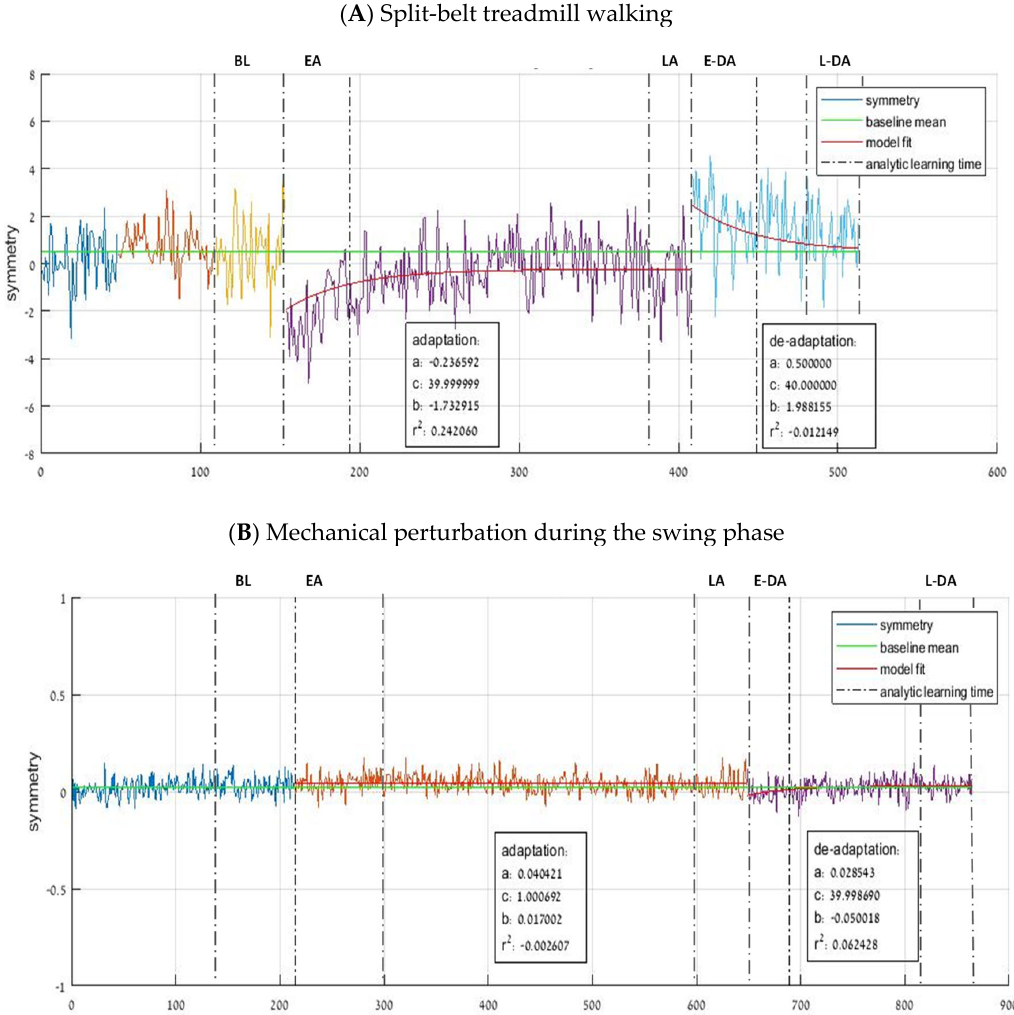
Figure 1. An example of kinematic adaptation data. Ground reaction forces (GRFs) and center of pressure (CoP) were sampled and recorded with Gaitfors software (ForceLink. 124. BV, Clemborg, The Netherlands). Here, we present adaptation and de-adaptation periods during ( A ) split-belt treadmill walking and ( B ) mechanical perturbation during swing phase, using an exponential decay function with the form of y = a + ( b × e − t c ) . The vertical lines represent the baseline period, the early-adaptation period, late-adaptation period, early de-adaptation period, and late de-adaptation period (See text for further details). Note: a—the final value that the exponential decay function approaches. b—the magnitude of adaptation or de-adaptation required from the first trial value to the value a. t—the stride number. c—the number of strides it will take to obtain 1 − e − 1 or approximately two-thirds of the adaptation or de-adaptation. r 2 —fitting of the curve. ( A ) split-belt treadmill walking, ( B ) mechanical perturbation during the swing phase. Note: x-axis is the time in milliseconds and y-axis is the symmetry index (SI, see text for elaboration). Perfect symmetry will result in an SI value of zero, a positive value indicates that the variable on the right side is less than the one measured on the left side and a negative value indicates that the variable on the left side is less than the one measured on the right side. Abbreviations: baseline period (BL); the early-adaptation period (EA); late-adaptation period (LA); early de-adaptation period (E-DA); and late de-adaptation period (L ‐ DA).